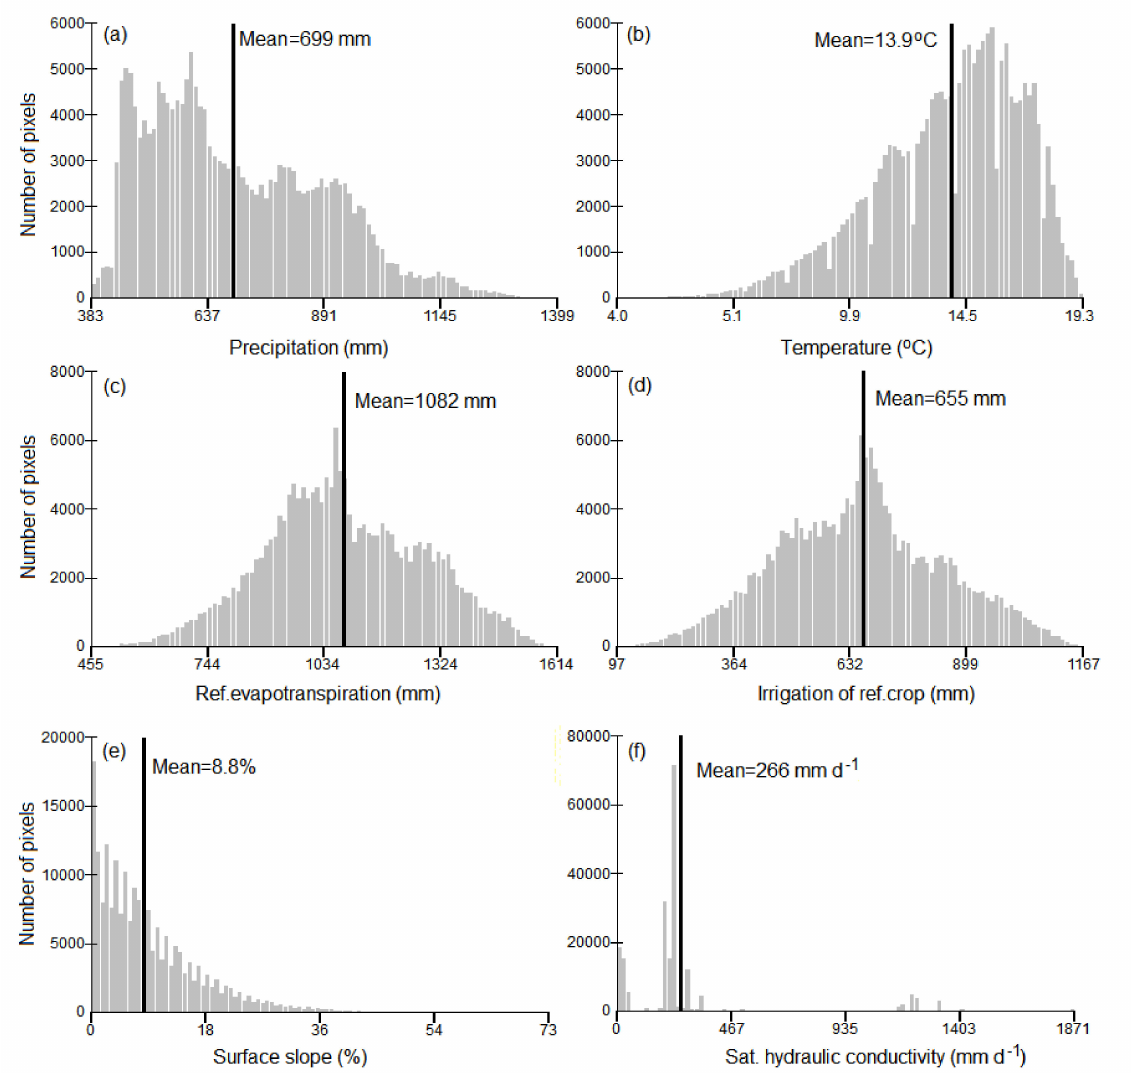
Figure 2. Histograms of mean annual values of ( a ) precipitation, ( b ) temperature, ( c ) reference evapotranspiration according to ASCE-standardized for short reference crops, ( d ) irrigation required for covering the deficit of annual reference evapo- transpiration for the period 1950–2000, ( e ) surface slope and ( f ) saturated hydraulic conductivity based on the pixel values of the respective raster datasets of Figure